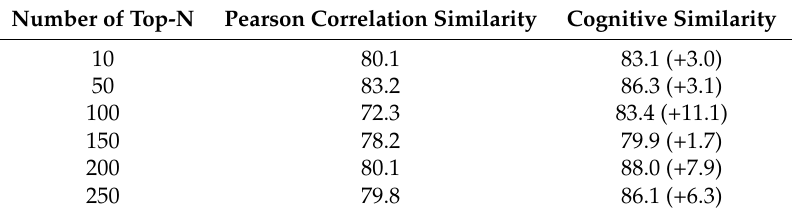
Table 2. F 1 metric comparison between the CF-Pearson Correlation Similarity and the CF-Cognitive Similarity.